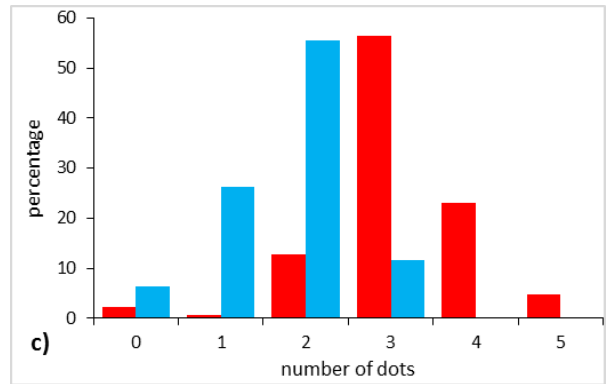
Figure 6. SEM images of ( a ) a single layer and ( b ) a tenfold stack of site-controlled InAs/GaAs QDs